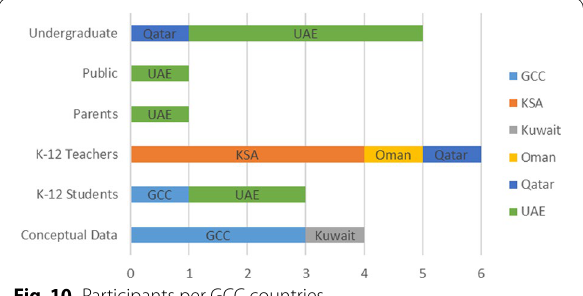
Fig. 10 Participants per GCC countries